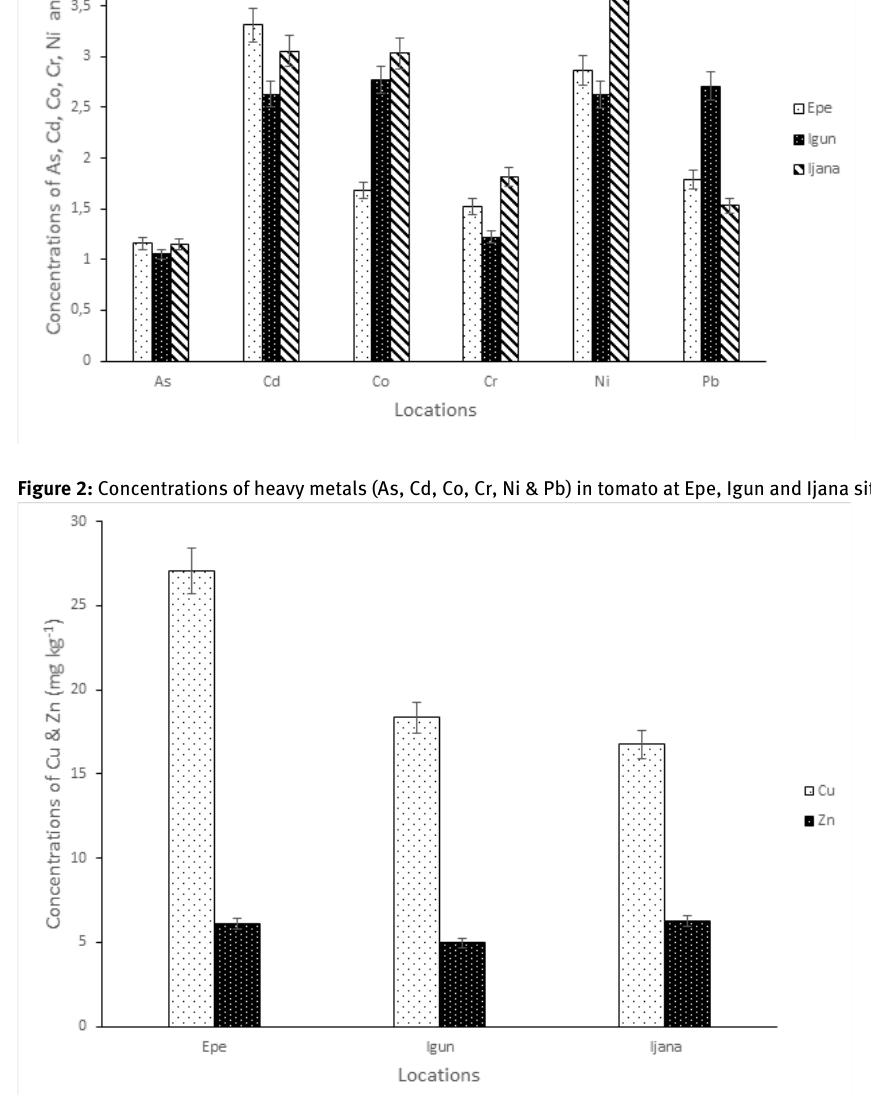
Figure 3: Concentrations of Cu & Zn in maize at Epe, Igun and Ijana